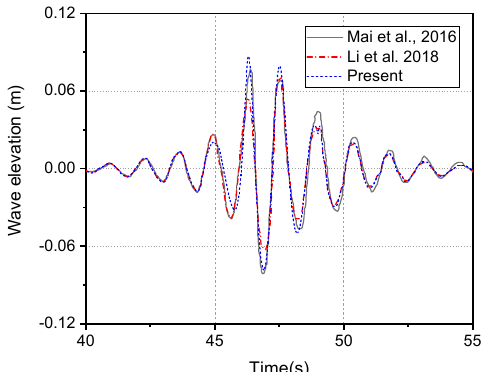
Figure 8. Wave elevation comparison at WG16 between experimental data [22], other CFD results [31] and present CFD results.